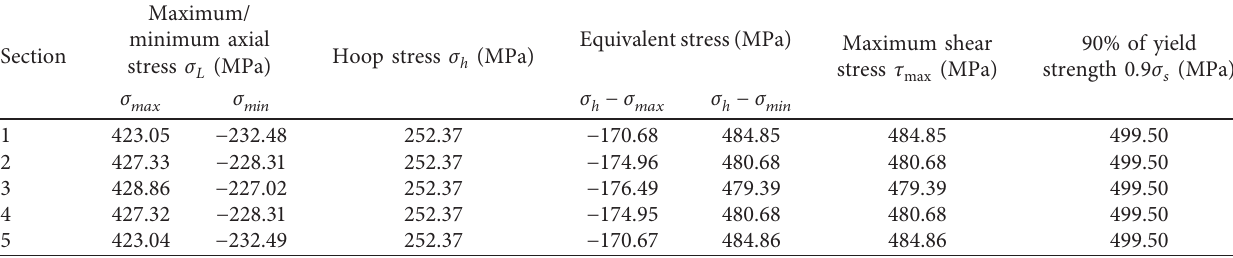
Table 1: Calculated stress results of FEM in five pipe sections.